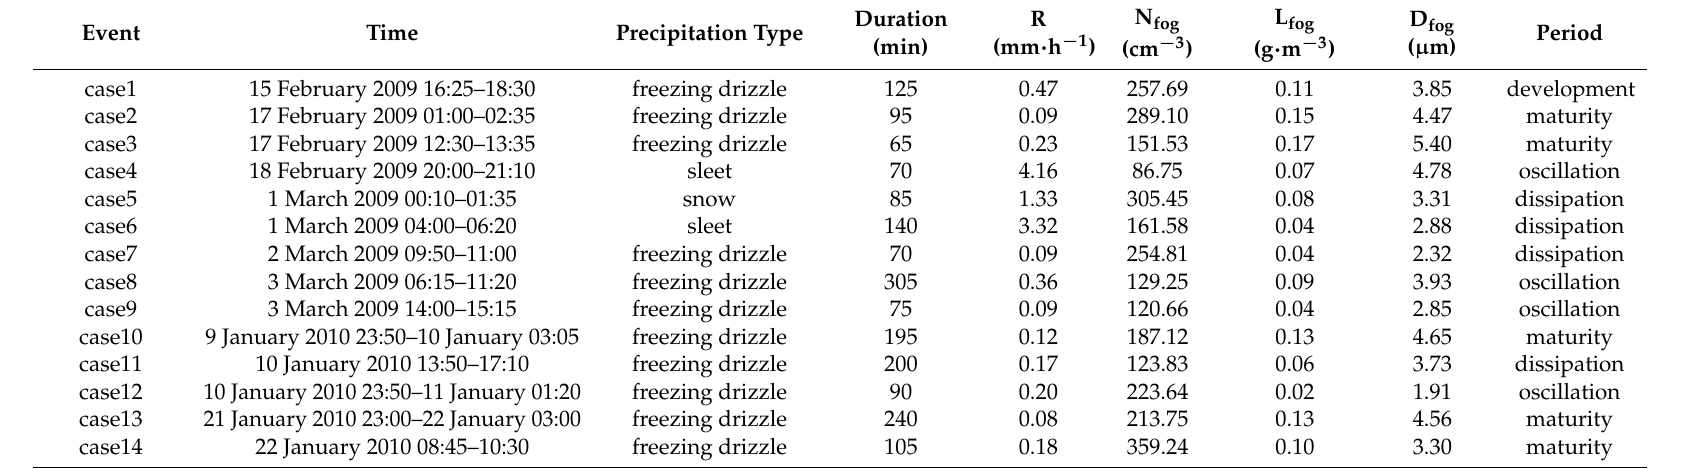
Table 1. The characteristics of precipitation and key microphysical properties of freezing fog in 14